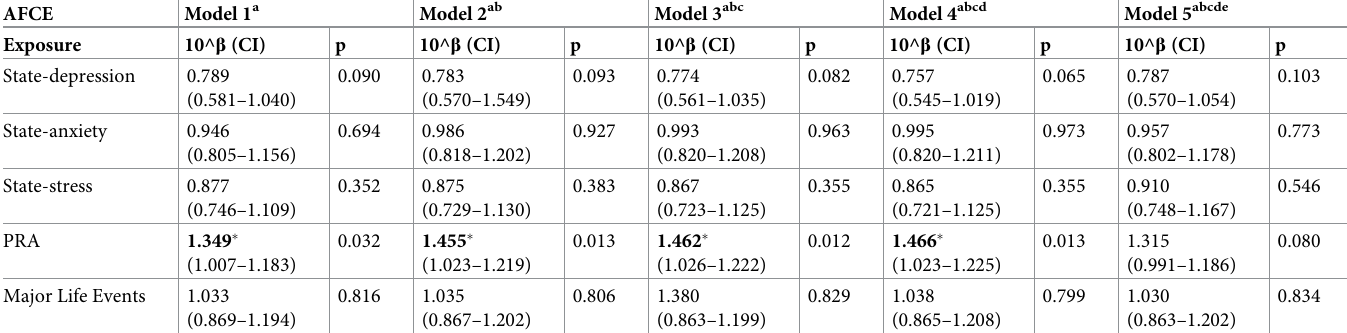
Table 3. Regression coefficients (10^ β ), confidence intervals (CI) and levels of significance (p-value) from the five-step regression analysis of state stress exposures and AFCE. The data are presented as 10^ β representing the factor by which the mean AFCE is multiplied for each unit increase in